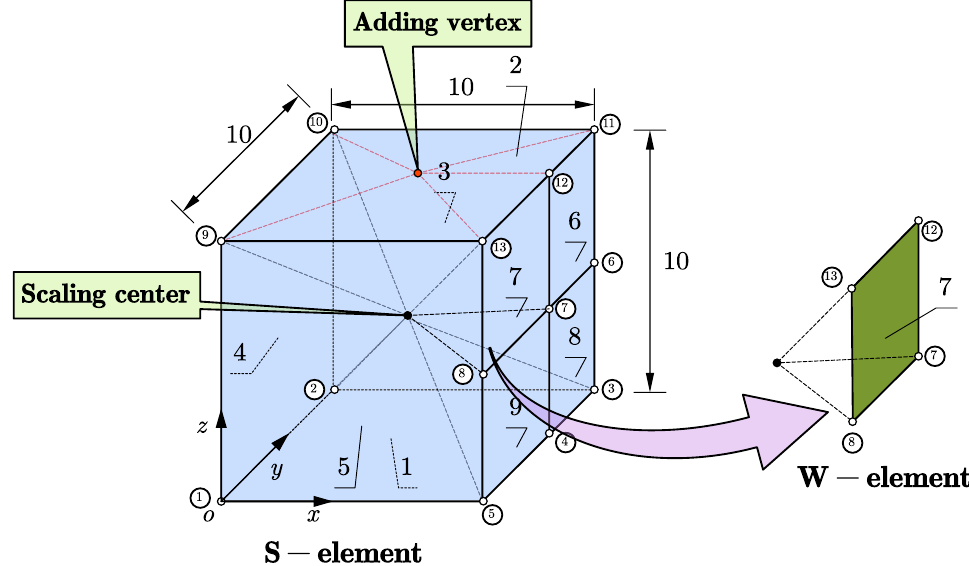
Figure 6. Topology of a polyhedron element and the treatment of the polygon facet.